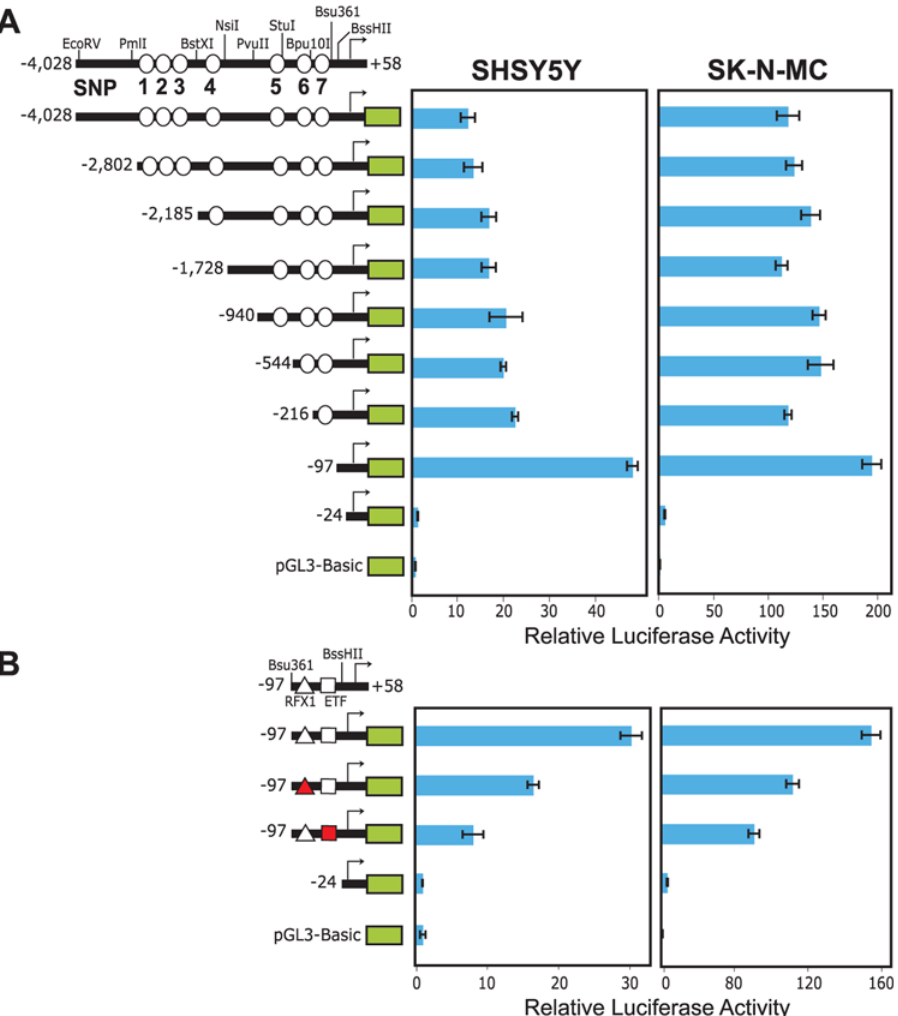
Figure 2. Luciferase-based expression analysis of the putative KIAA0319 promoter region. (A) Luciferase-expressing constructs containing different portions of the KIAA0319 promoter region from the non-risk haplotype were generated. Restriction sites relevant to the creation of the depicted ‘‘deletion series’’ of constructs are shown, as are the locations of SNPs 1–7 (see Figure 1A). Each construct was transfected into SHSY5Y and SK-N-MC neuronal cell lines and subsequent luciferase expression measured; all assays were performed in quadruplicate and repeated at least three times. RLA for each construct was scaled such that pGL3-Basic activity equaled 1.0. Error bars represent the standard error of the mean. The green box in each construct represents the proximal end of KIAA0319 , with the arrow indicating the TSS. (B) Additional studies were performed with constructs containing disrupted RFX1- or ETF-binding sites (represented by a red triangle and red square, respectively).